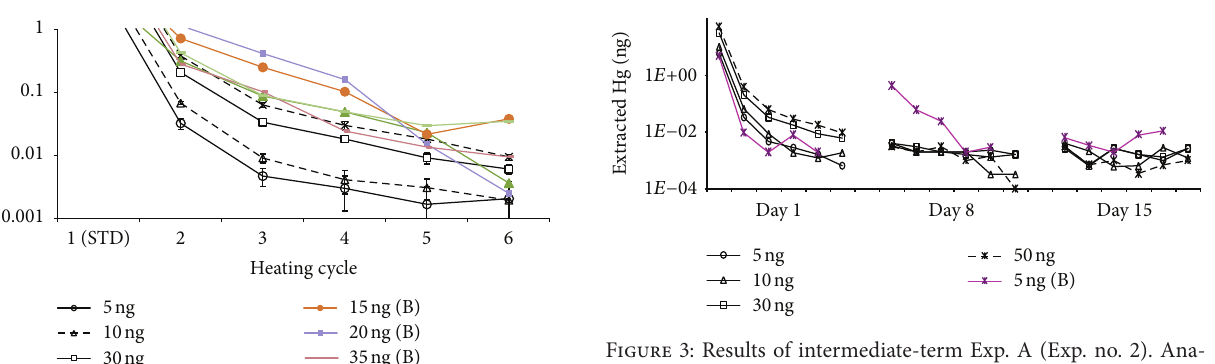
Figure 3: Results of intermediate-term Exp. A (Exp. no. 2). Ana- lytical intensities from adsorption tubes dosed with four different amounts of mercury (5, 10, 30, and 50 ng): six consecutive runs made after (a) 1 day, (b) 8 days, and (c) 15 days. 5ng (B) represents observation from 2nd heating cycle in our previous investigation [14].